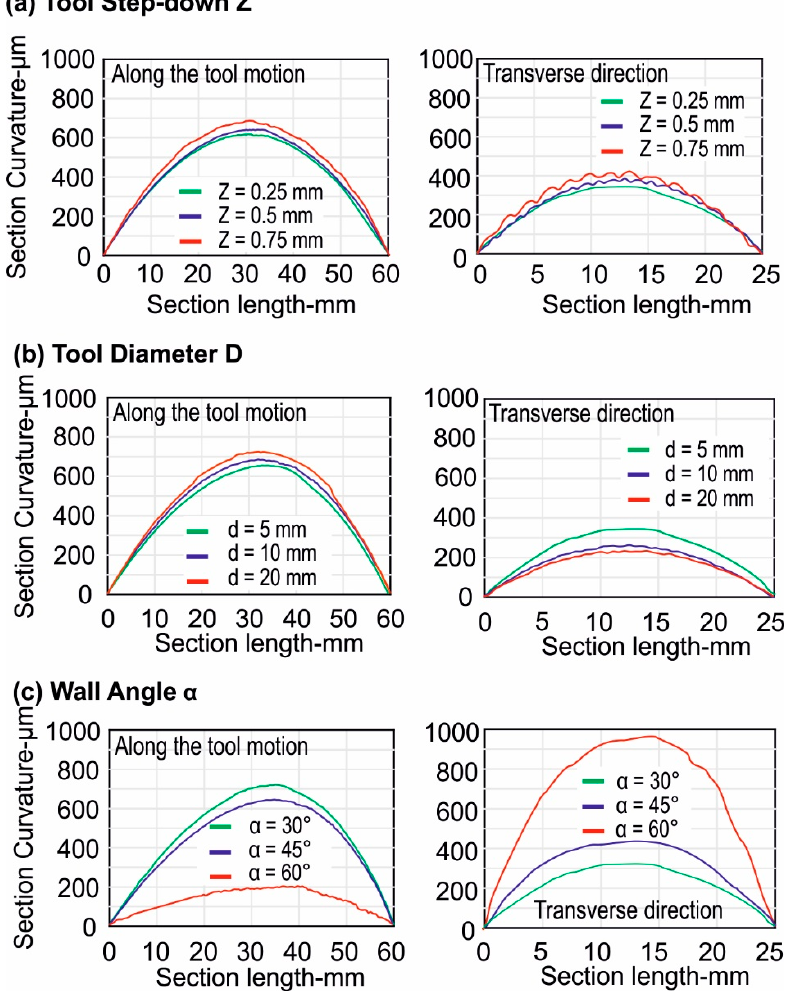
Figure 16. Curvature of the strips cut along and in the transverse direction of tool motion for ( a ) tool step-down Z, ( b ) tool diameter D, and ( c ) wall angle α .